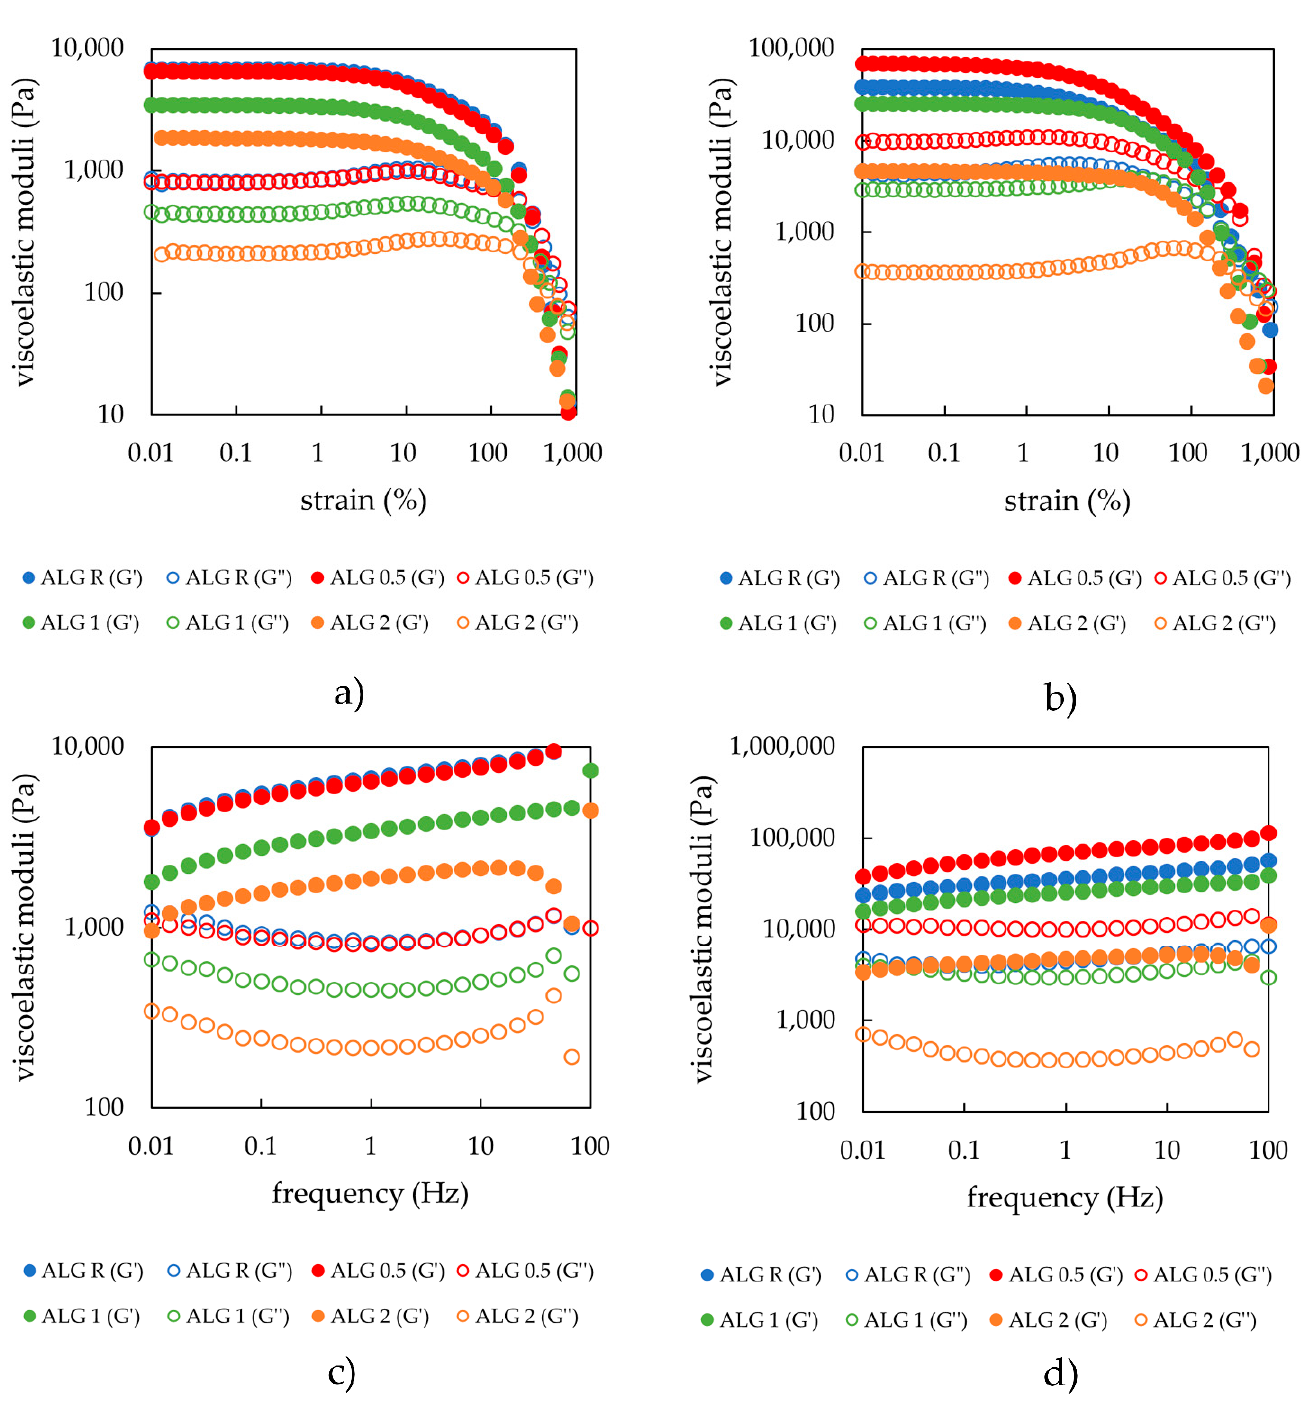
Figure 4. ( a ) Strain sweep of alginate hydrogels with the addition of different lecithin concentrations (0, 0.5, 1, and 2 wt.%) after preparation; ( b ) strain sweep of alginate hydrogels with different lecithin concentrations (0, 0.5, 1, and 2 wt.%) after drying and rehydration of the xerogels (frequency applied 1 Hz); ( c ) frequency sweep of alginate hydrogels with different lecithin concentrations (0, 0.5, 1, and 2 wt.%) after preparation; ( d ) frequency sweep of alginate hydrogels with different lecithin concentrations (0, 0.5, 1, and 2 wt.%) after drying and rehydration of the xerogels.